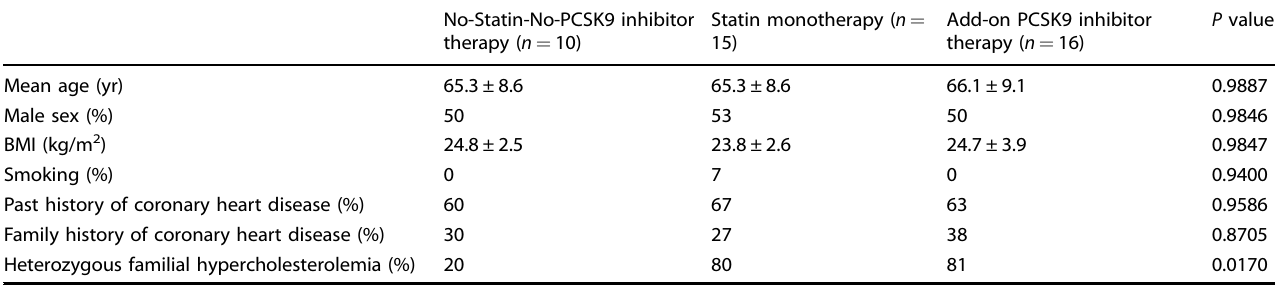
Table 3. Baseline characteristics of the paired longitudinal study